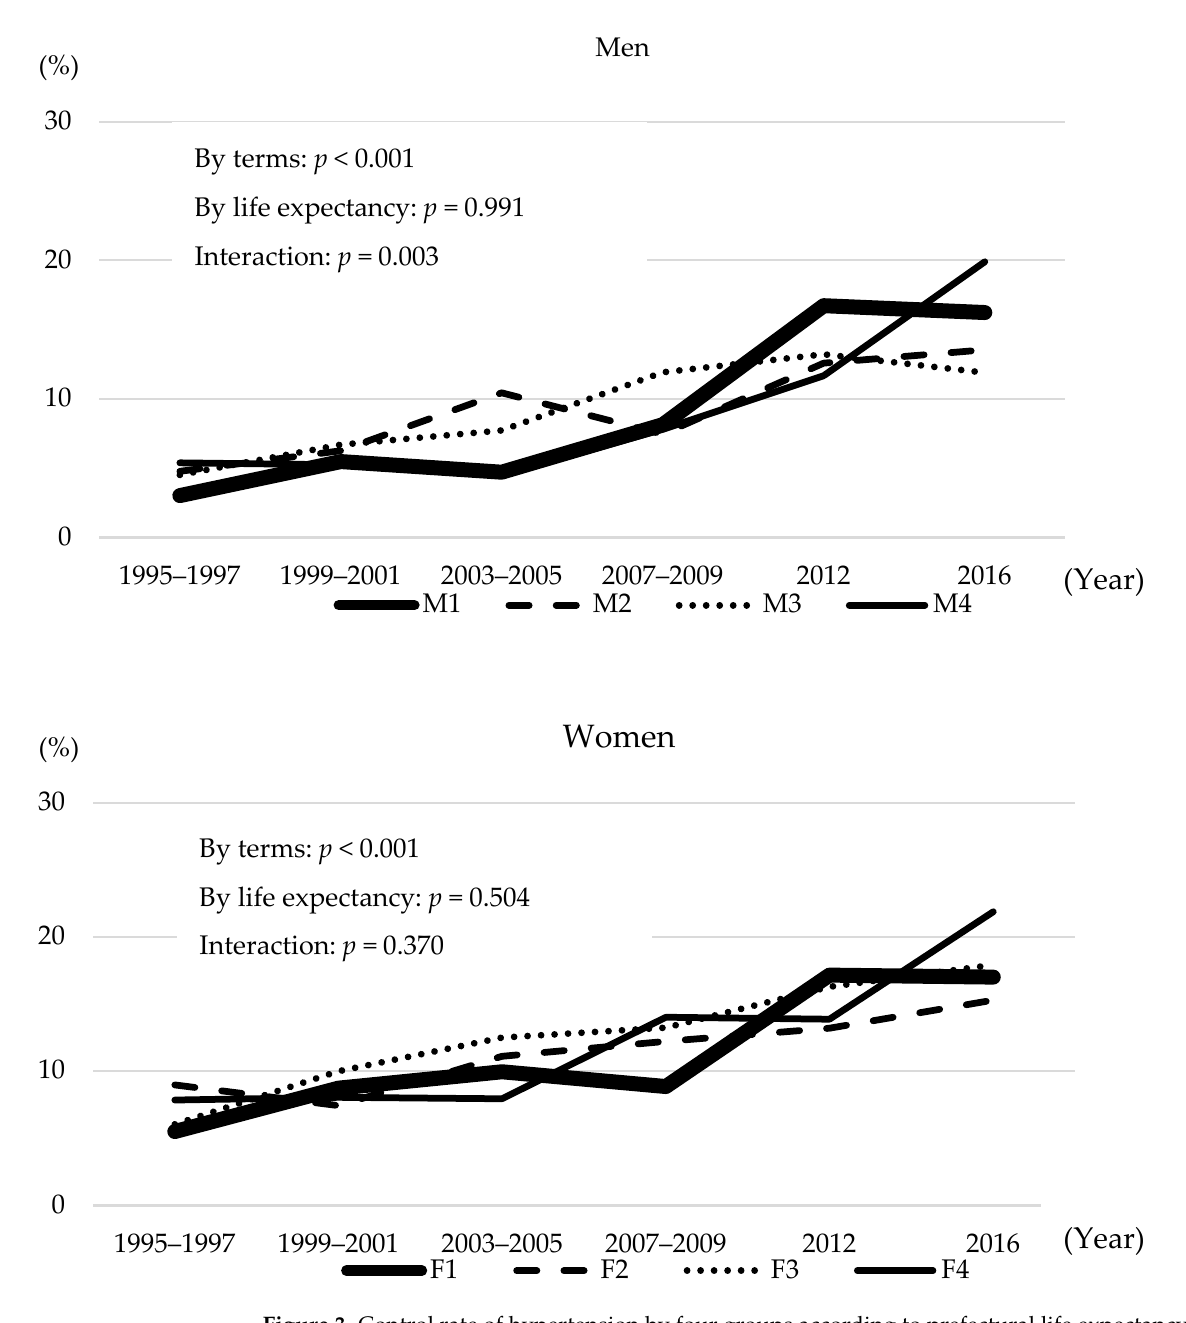
Figure 3. Control rate of hypertension by four groups according to prefectural life expectancy.